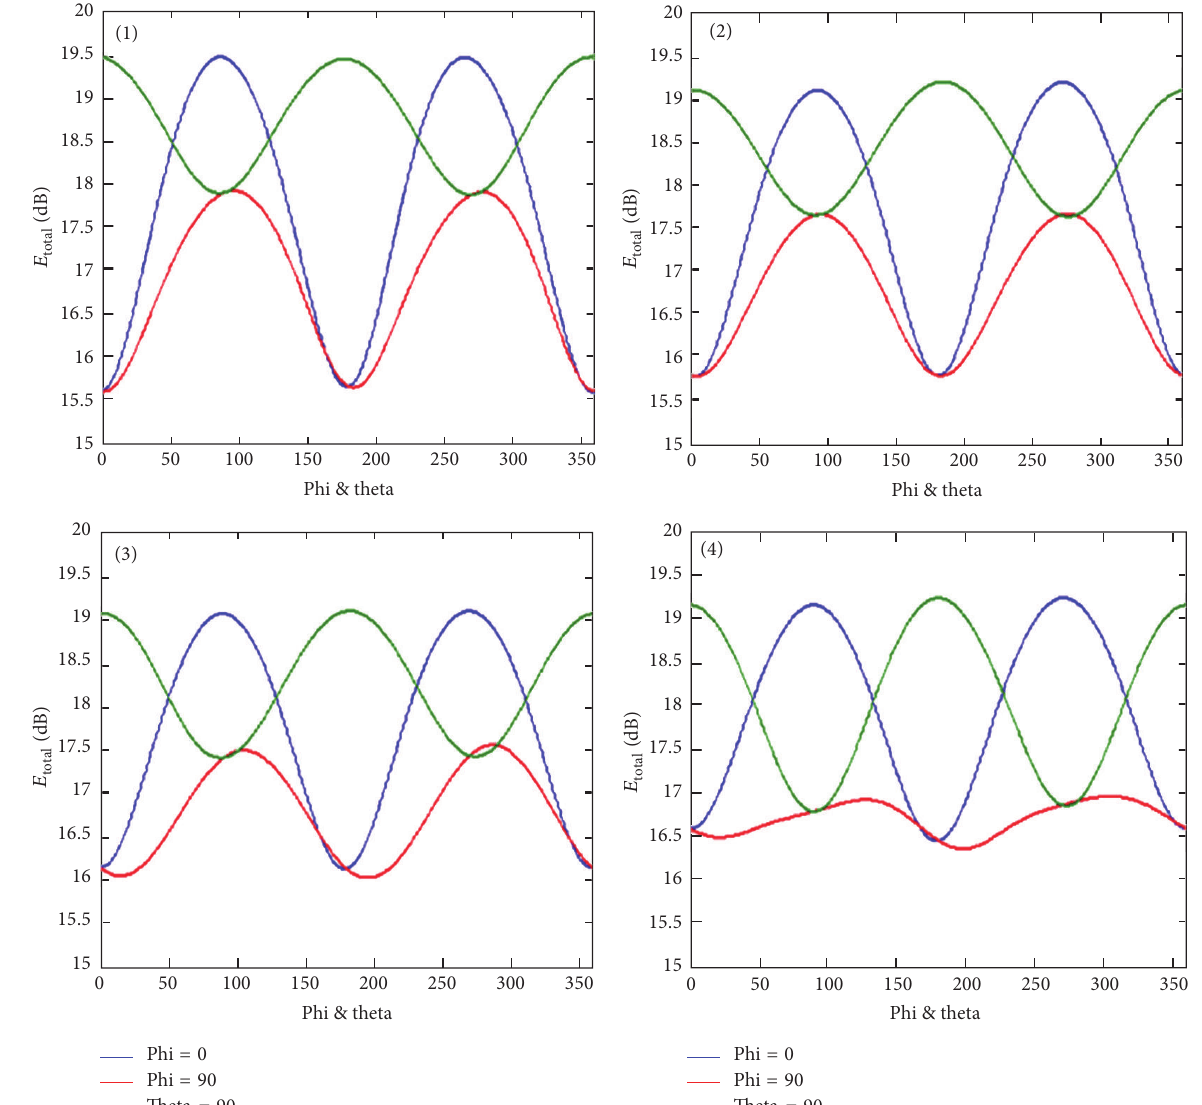
Figure 23: The 𝐸 total field of each 3D spherical antenna (Table 8) in the plans: 𝑥𝑧 , 𝑦𝑧 , and 𝑥𝑦 .